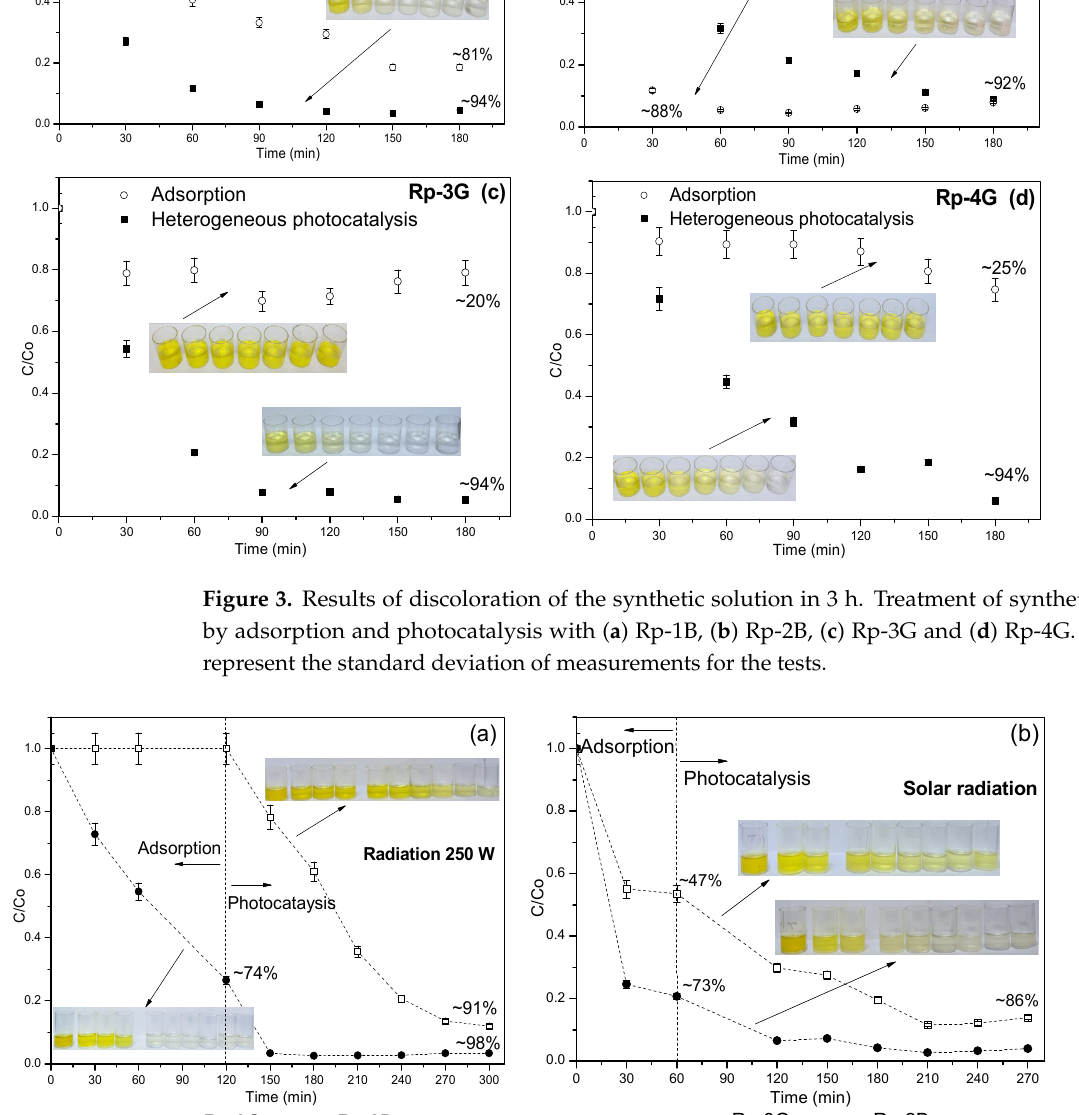
Figure 4. Results of the discoloration test using the industrial effluent: ( a ) artificial radiation (250 W vapor lamp) and ( b ) solar radiation. Error bars represent the standard deviation of measurements for the tests.